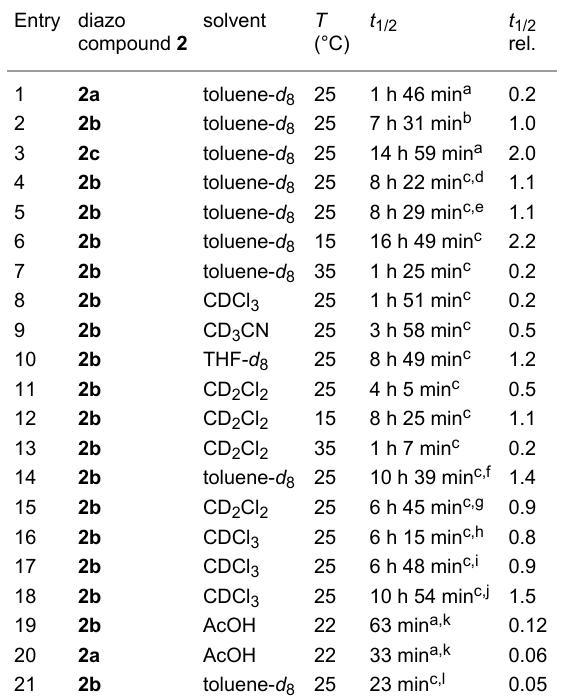
Table 1: Reaction conditions and half-lives ( t 1/2 ) of 2a – c